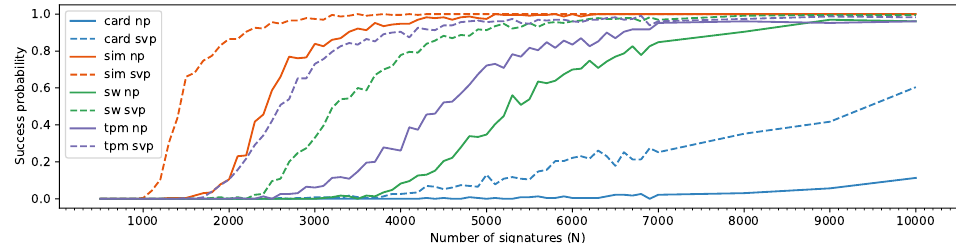
Figure 8: Success rate (averaged over all analyzed dimensions) of SVP (dashed line) and Babai’s nearest plane (NP, solid line) algorithm, using geometric bounds.